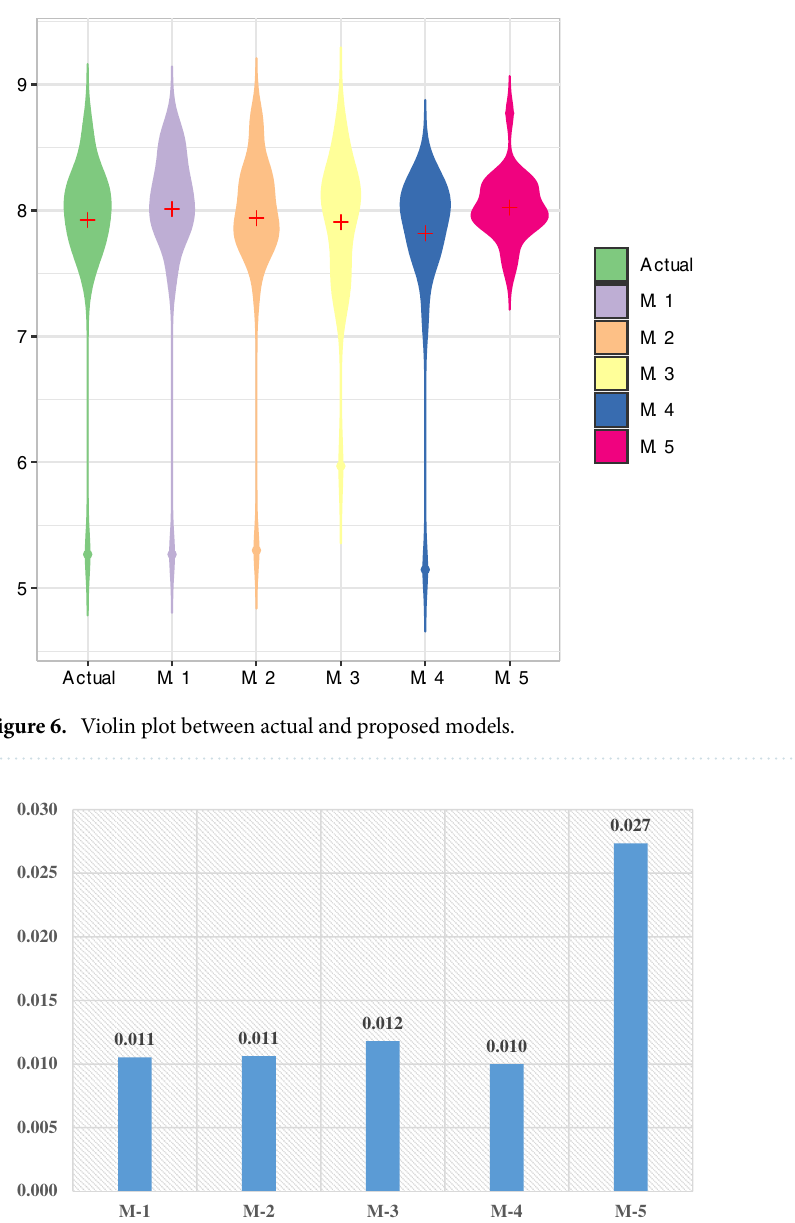
Figure 7. d-factor values for each proposed